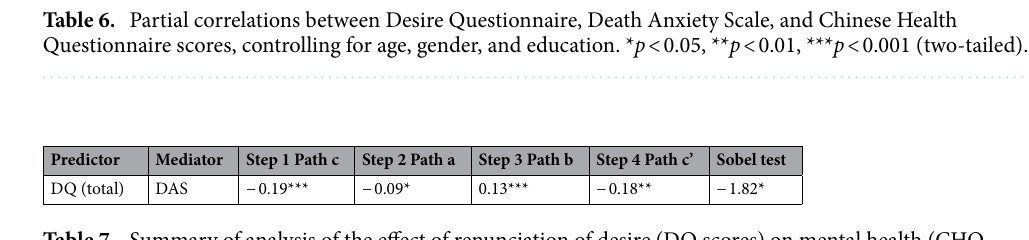
Table 7. Summary of analysis of the effect of renunciation of desire (DQ scores) on mental health (CHQ scores) mediated by death anxiety (DAS scores). The values in the table are standardized regression coefficients ( β ). *** p < 0.001, ** p < 0.01, * p <